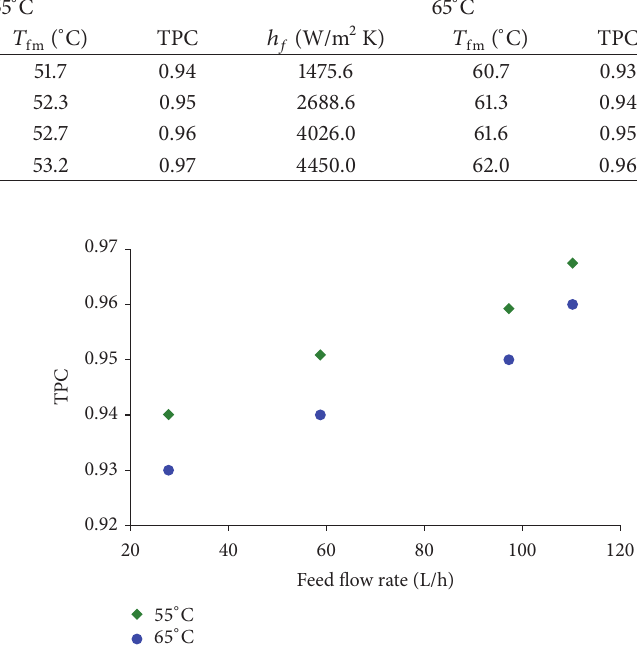
Figure 10: The effect of the feed flow rate on the temperature polarization coefficient at a constant 92 kPa vacuum degree and feed temperatures of 55 and 65 ∘